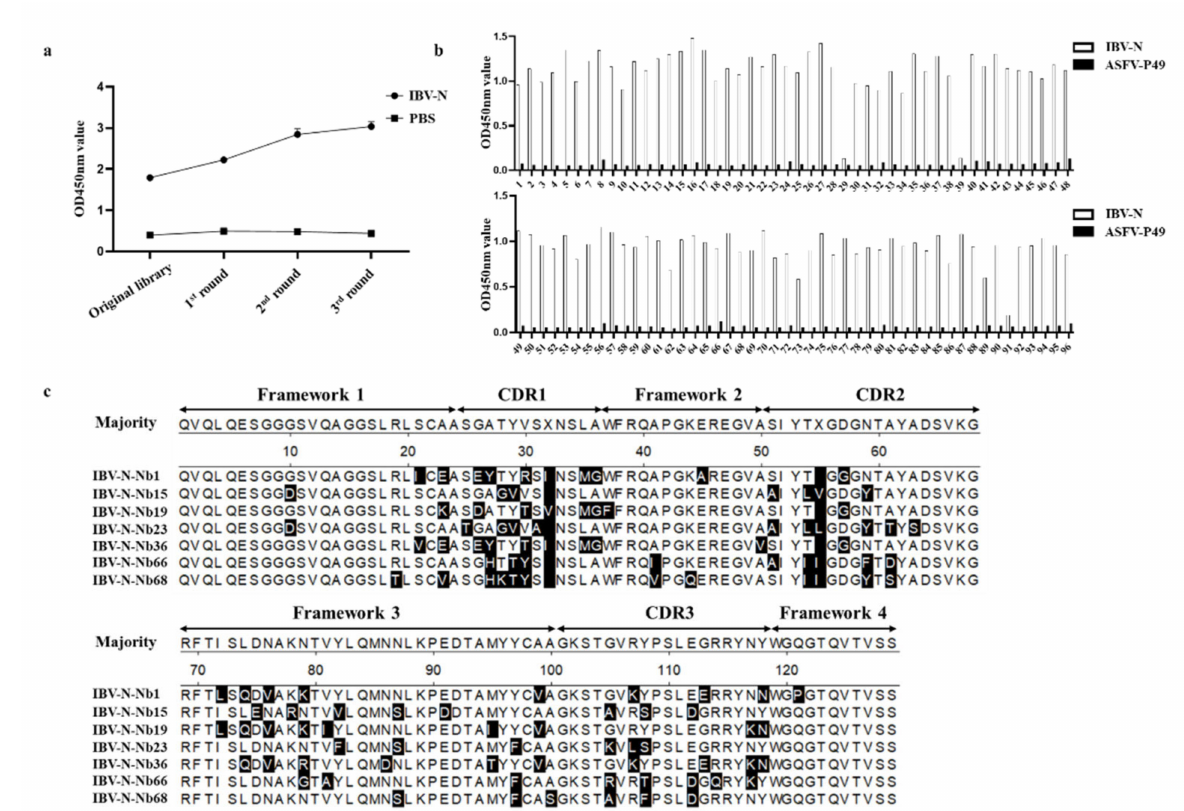
Figure 3. Screening the specific nanobodies against IBV-N protein by phage display technology. ( a ) Detection of specific phage enrichment with ELISA. ( b ) Identification of the periplasmic extracts from the 96 clones specifically binding to the IBV-N protein with indirect ELISA, and 93 clones were identified as positive (the P49 protein of African swine fever virus (ASFV-P49), which was expressed in E. coli (BL21) with the same expression method as IBV-N protein, was treated as the negative control). ( c ) Alignment of amino acid sequence of 7 screened nanobodies, and the sequences were grouped according to their CDRs (Shade residues with solid black that differ from the